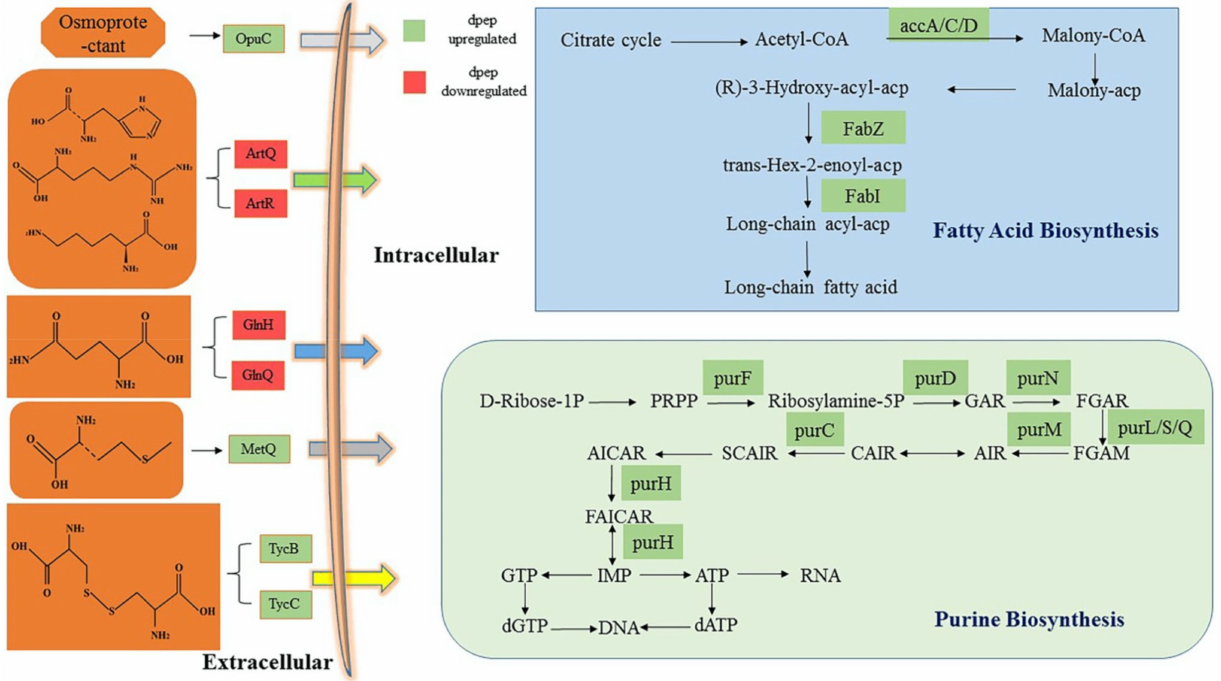
Figure 5. Schematic diagram of DEGs involved in crucial metabolism pathway of fatty acid, ABC transporters, purine biosynthesis in dpep/MRS, and depe/dpro comparison. Genes with green background represent up-regulation and red background represent down-regulation for